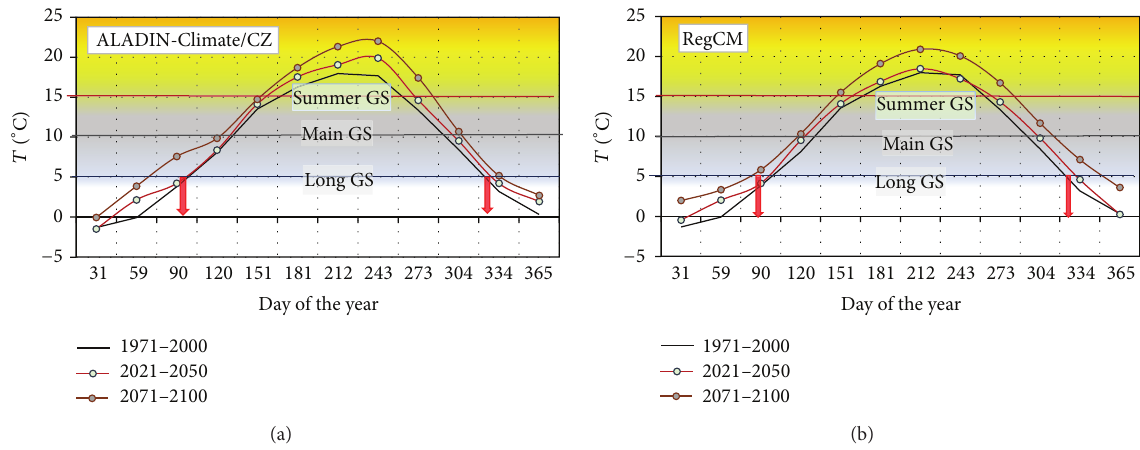
Figure 2: Daily temperatures for observed gridded dataset (1971–2000) and ALADIN-Climate/CZ and RegCM simulation values after bias correction for A1B scenario runs (2021–2050 and 2071–2100) for Elbe River lowland. Schematic delimitation of the long growing season ≥ 5 ∘ C), the main growing season ( 𝑇 ≥ 10 ∘ C), and the summer growing season ( 𝑇 ( 𝑇 mean mean